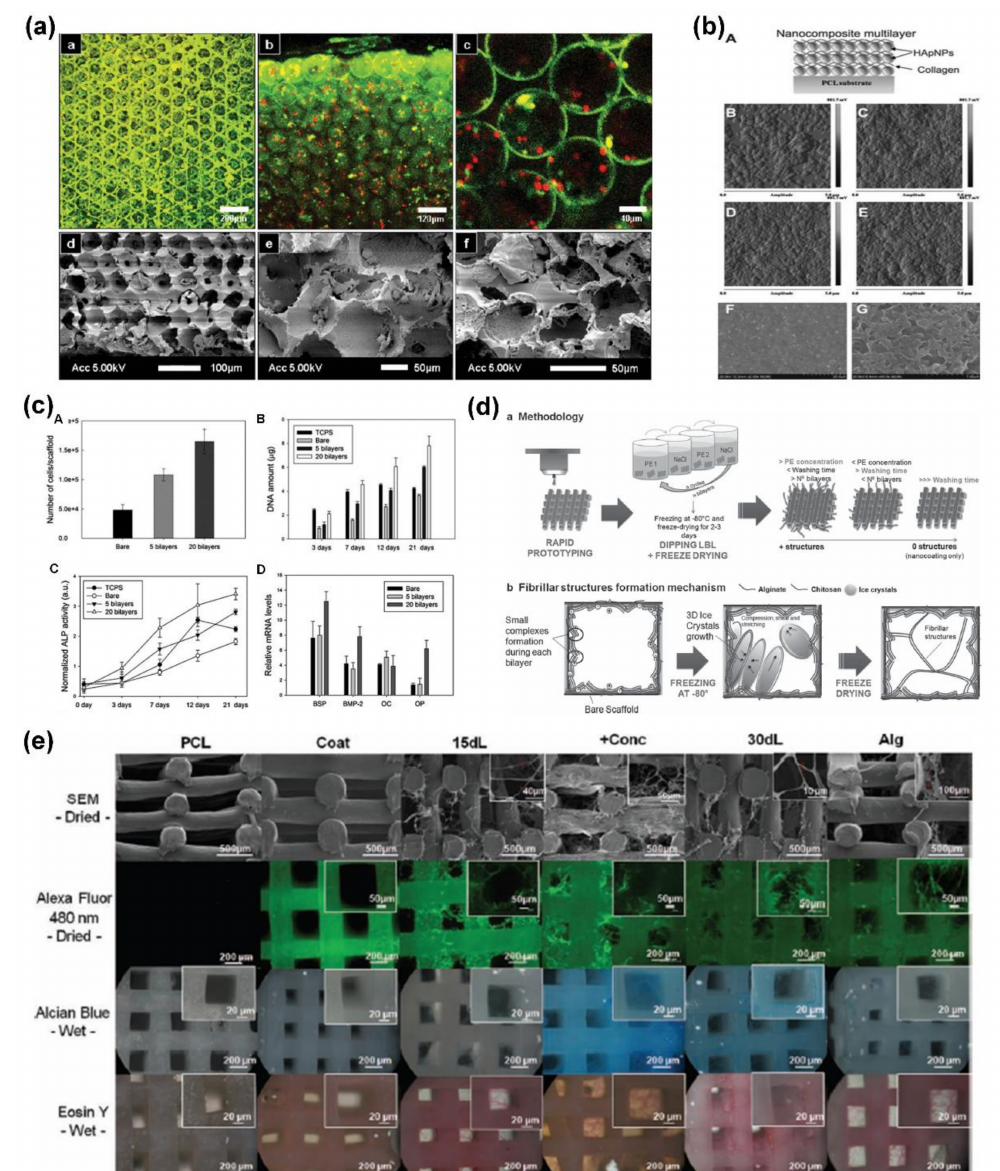
Figure 5. ( a ) Confocal images of inverted colloidal crystal scaffolds cultured with thymic epithelial cells and monocyte cells; ( b ) illustration of LbL multilayer nanocomposite coating with hydroxyapatite and collagen on substrates, and the AFM images of multilayers with different numbers of bilayers; ( c ) hMSCs adhesion and their quantification of DNA amounts to bare and coated scaffolds, and alkaline phosphatase activity and relative mRNA expression during the culture of hMSCs on various substrates; ( d ) steps and mechanism for developing the hierarchical and hybrid 3D scaffolds and ( e ) representative images of the structures of these scaffolds. Reprinted from [49,92,94] with permissions from Wiley-VCH and Royal Society of